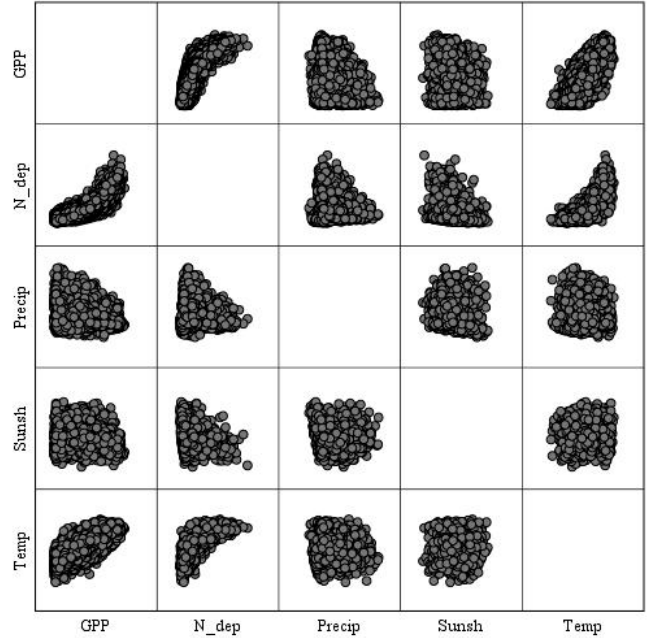
Figure A5. Correlation matrix using the original values of N deposition for the class grasslands and the year 2000.